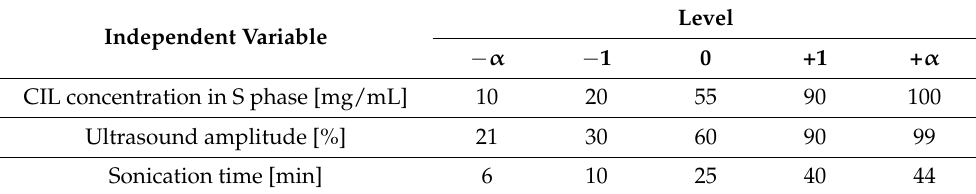
Table 6. Independent variables and their levels used for Central Composite Design studies for LASP+sonication characterization and